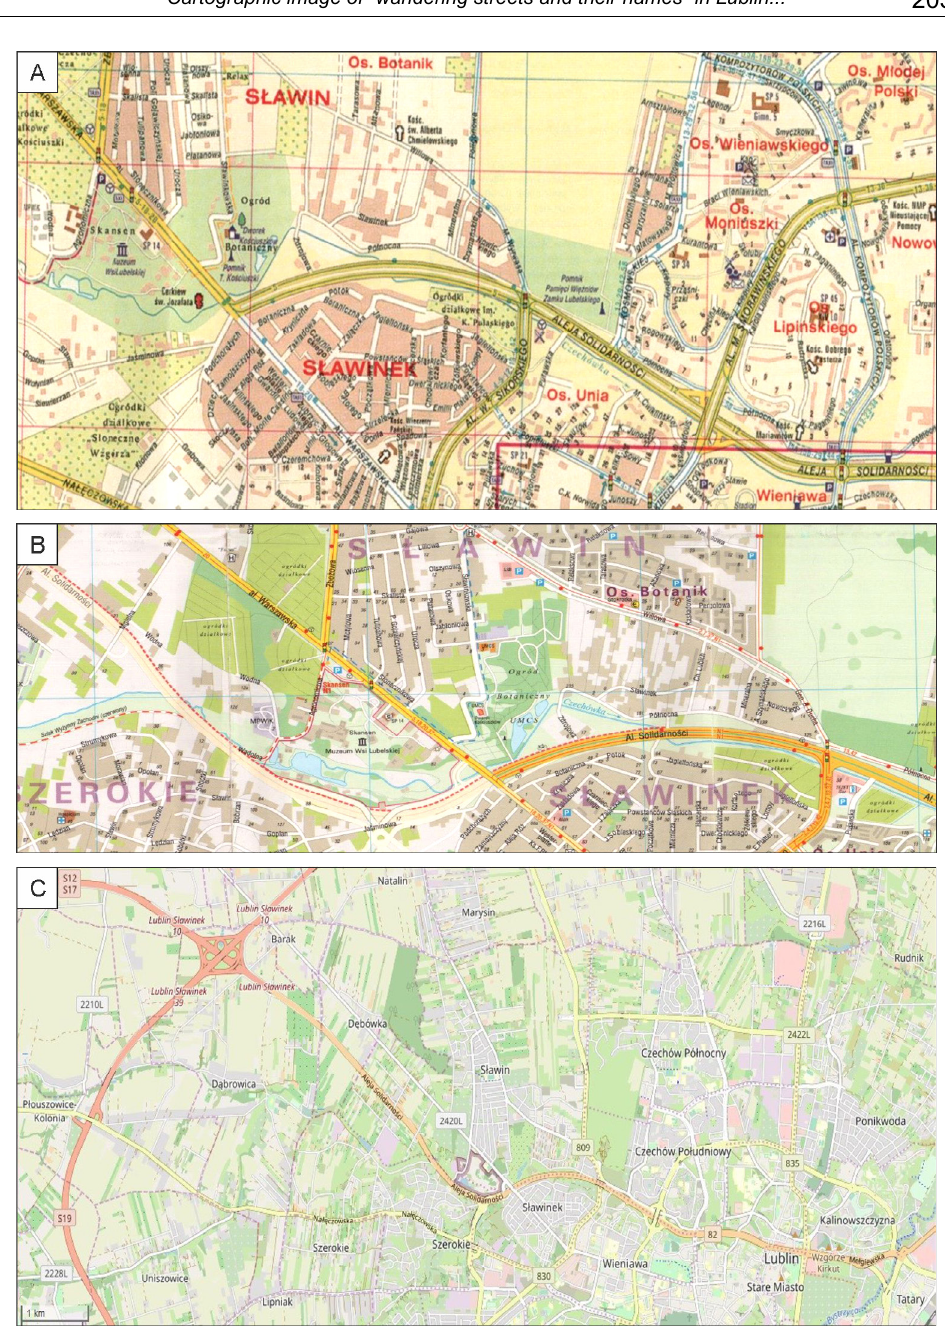
Fig. 7. Solidarności Avenue on maps of Lublin: A – Solidarności Avenue on the city map from 2001 (source: Lublin , original scale 1:20,000, PPWK, 2001); B – the planned extension of Solidarności Avenue on the city map from 2014 (source: Lublin , original scale 1:15,000, Kartpol, 2014); C – the extended part of Solidarności Avenue in 2019 (source: